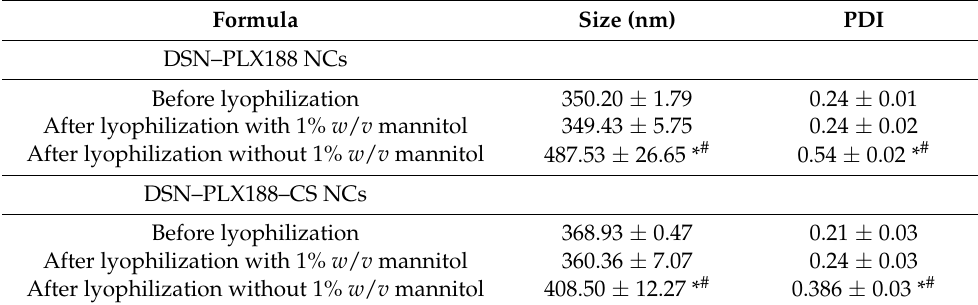
Table 3. Lyophilization effects on the size and the size distribution of the selected